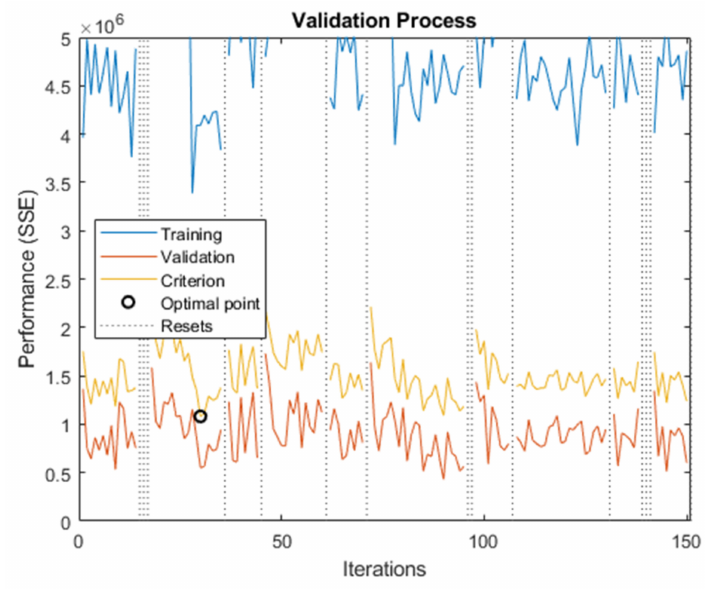
Figure 9. Validation process